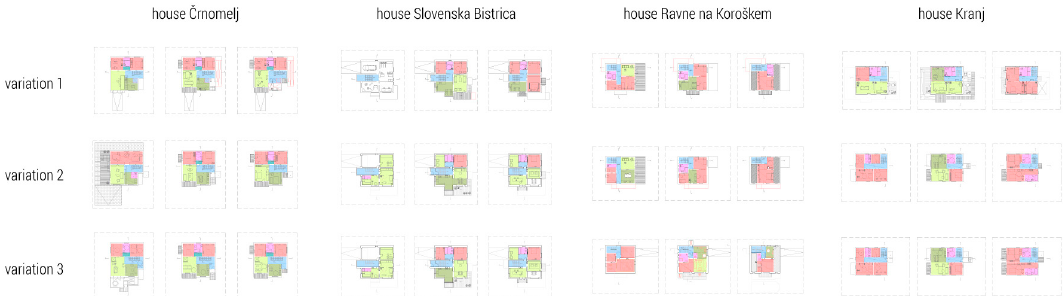
Figure 4. The 12 floor plan solutions, to four houses in different locations, obtained during the first workshop. The space functions were colour-coded by the students. Authors: attendees of Student Workshop 1, 2021.